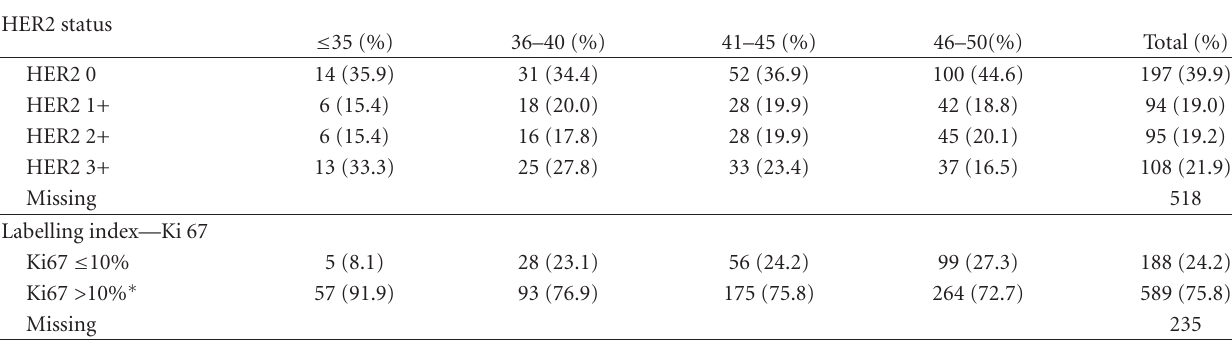
Table 4: Human epidermal growth factor receptor 2 (HER2)-neu and labelling index according to age. Younger age correlates with HER2- neu positive status and high Ki67.